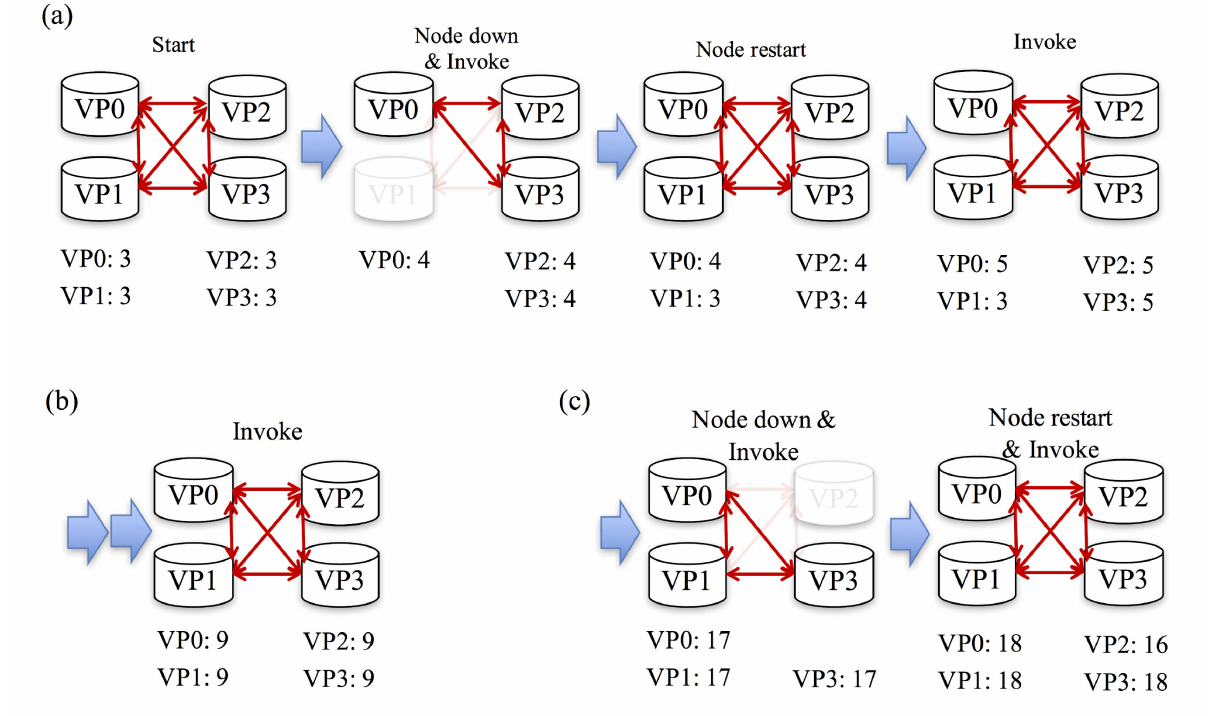
Figure 4. The blockchain in the mobile health data update test when one of validating peers (VPs) was down. The blockchain height of each VP is shown. (a) Robustness of the blockchain network against network failure. (b) Correction of the inconsistency by ledger synchronization. (c) Rejoining the Practical Byzantine Fault Tolerance consensus after another network